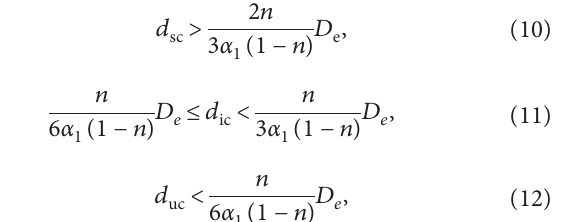
Table 3: Mass percentage of incoming PSs in different soil media particles. Proportion characteristics of mass percentage for different incoming sediments in size clogging for different soil skeletons in size